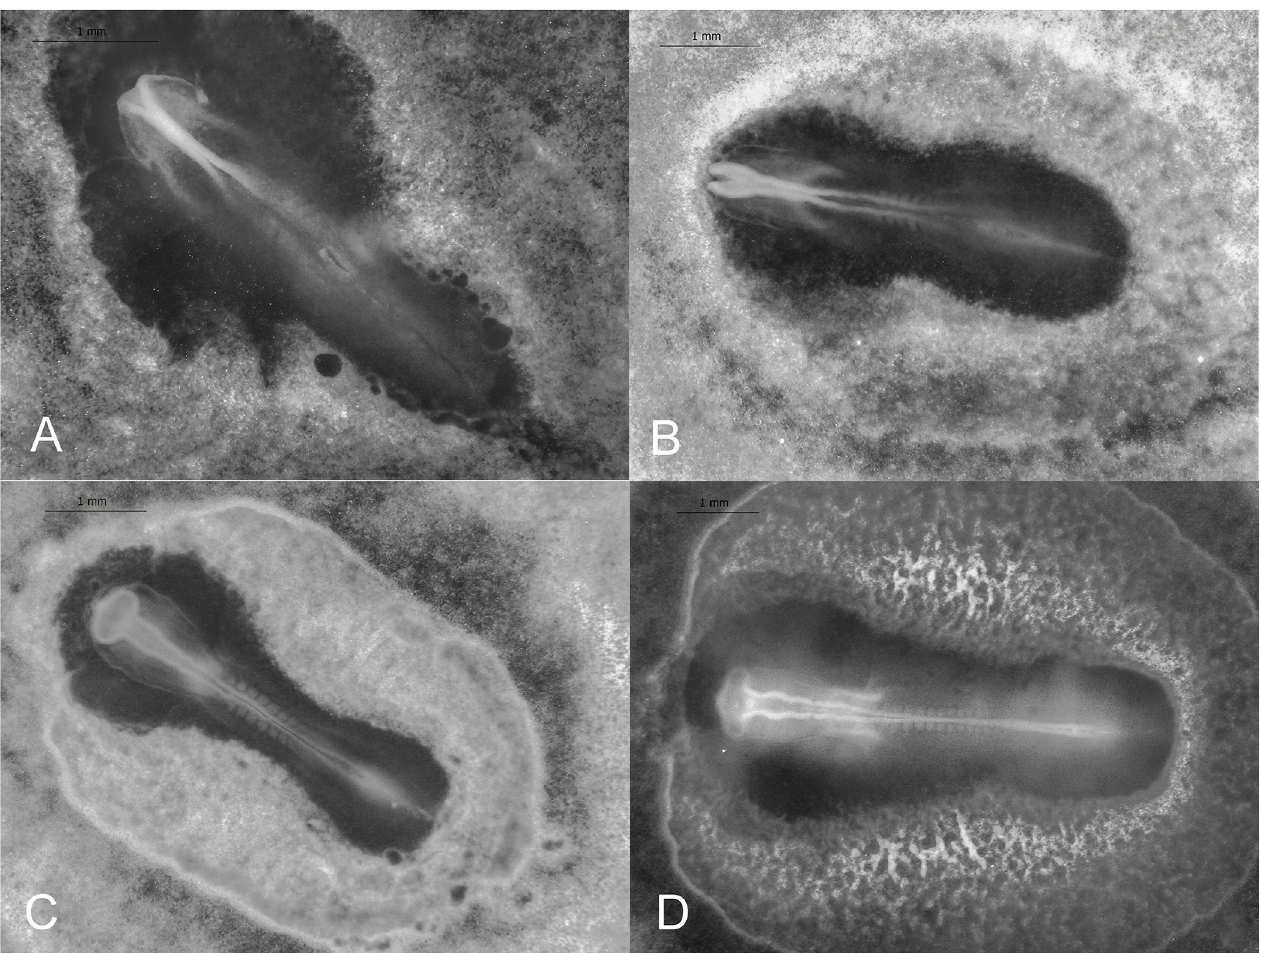
Fig 3. Stages 7–10 (30–54 h) of the California valley quail embryological stages of development. (A) Stage 7, one somite pair visible. (B) Stage 8, four somite pairs with blood islands present. (C) Stage 9, seven somite pairs with primordia of the heart. (D) Stage 10, 10 somite pairs and 3 brain vesicles visible. Stage 17 (74–84 h). Nasal pits visible. Limb-areas still flat. Cervical flexure is bent more towards the body, but the angle is still > 90˚. Amnion extends toward trunk. Allantois not yet formed. Embryo length: 6.71 ± 0.16 mm ( N = 5; Fig 5C). Stage 18 (78–84 h). First appearance of wing-bud. Darkening ridge of cells demarcate the beginning of wing formation. Tail bud has rotated to the right. Amnion enclosed except for small oval on the trunk. Embryo length: 6.85 ± 0.91 mm ( N = 6; Fig 5D). Stage 19 (90 h). Limb-buds are slightly enlarged. Maxillary process has become distinct. The 2nd visceral arch protrudes slightly. Tail-bud is curved and pointing toward the body. Diencephalon is at wing level. Wing-bud length: 1.12 ± 0.10 mm ( N = 3). Wing-bud width: 0.30 ± 0.08 mm ( N = 3). Embryo length: 7.16 ± 0.48 mm ( N = 2; Fig 6A). Stage 20 (90–96 h). Wing-buds are longer than leg-buds. Both wing- and leg-buds are longer than wide. Arches I and II are equal in length. The third arch extends in length and becomes prominent. Embryo has rotated towards itself and completed rotation. The embryo’s trunk is in a straight line. Allantois has thinned and extended to head. Eye pigmentation is faint. Wing-bud length: 1.11 ± 0.04 mm ( N = 4). Wing-bud width: 0.28 ± 0.03 mm ( N = 4). Leg-